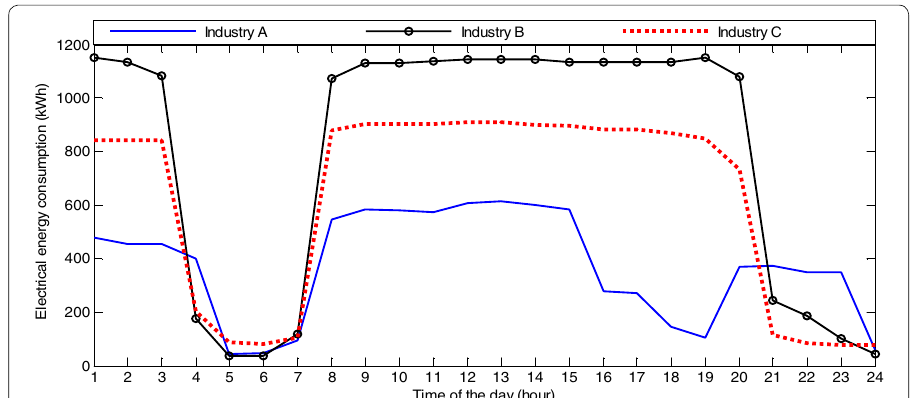
Fig. 1 Daily load profile for the industries